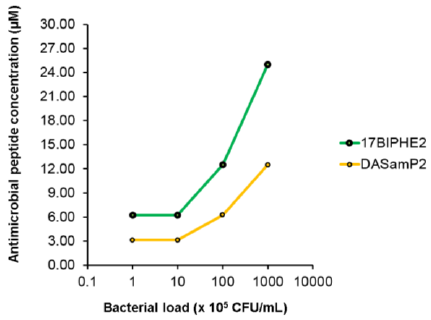
Figure 3. The biofilm inhibition concentration of DASamP2 or 17BIPHE2 depends on the initial bacterial density. The higher the initial bacterial load, the higher the peptide concentration needed to inhibit biofilm